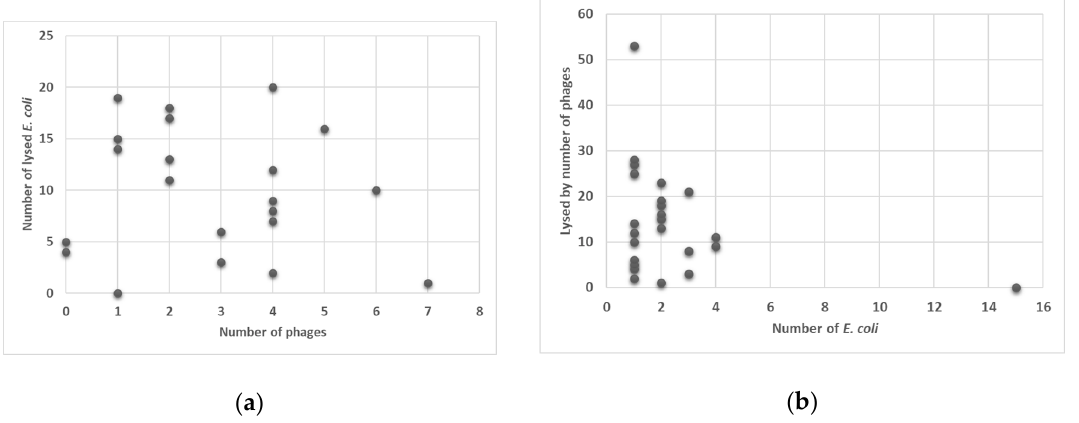
Figure 1. Ability of phages to lyse none, one, or more E. coli ( y -axis) ( a ) and susceptibility of the E. coli isolates to be lysed by none, one, or more of the 60 phages ( y -axis) ( b